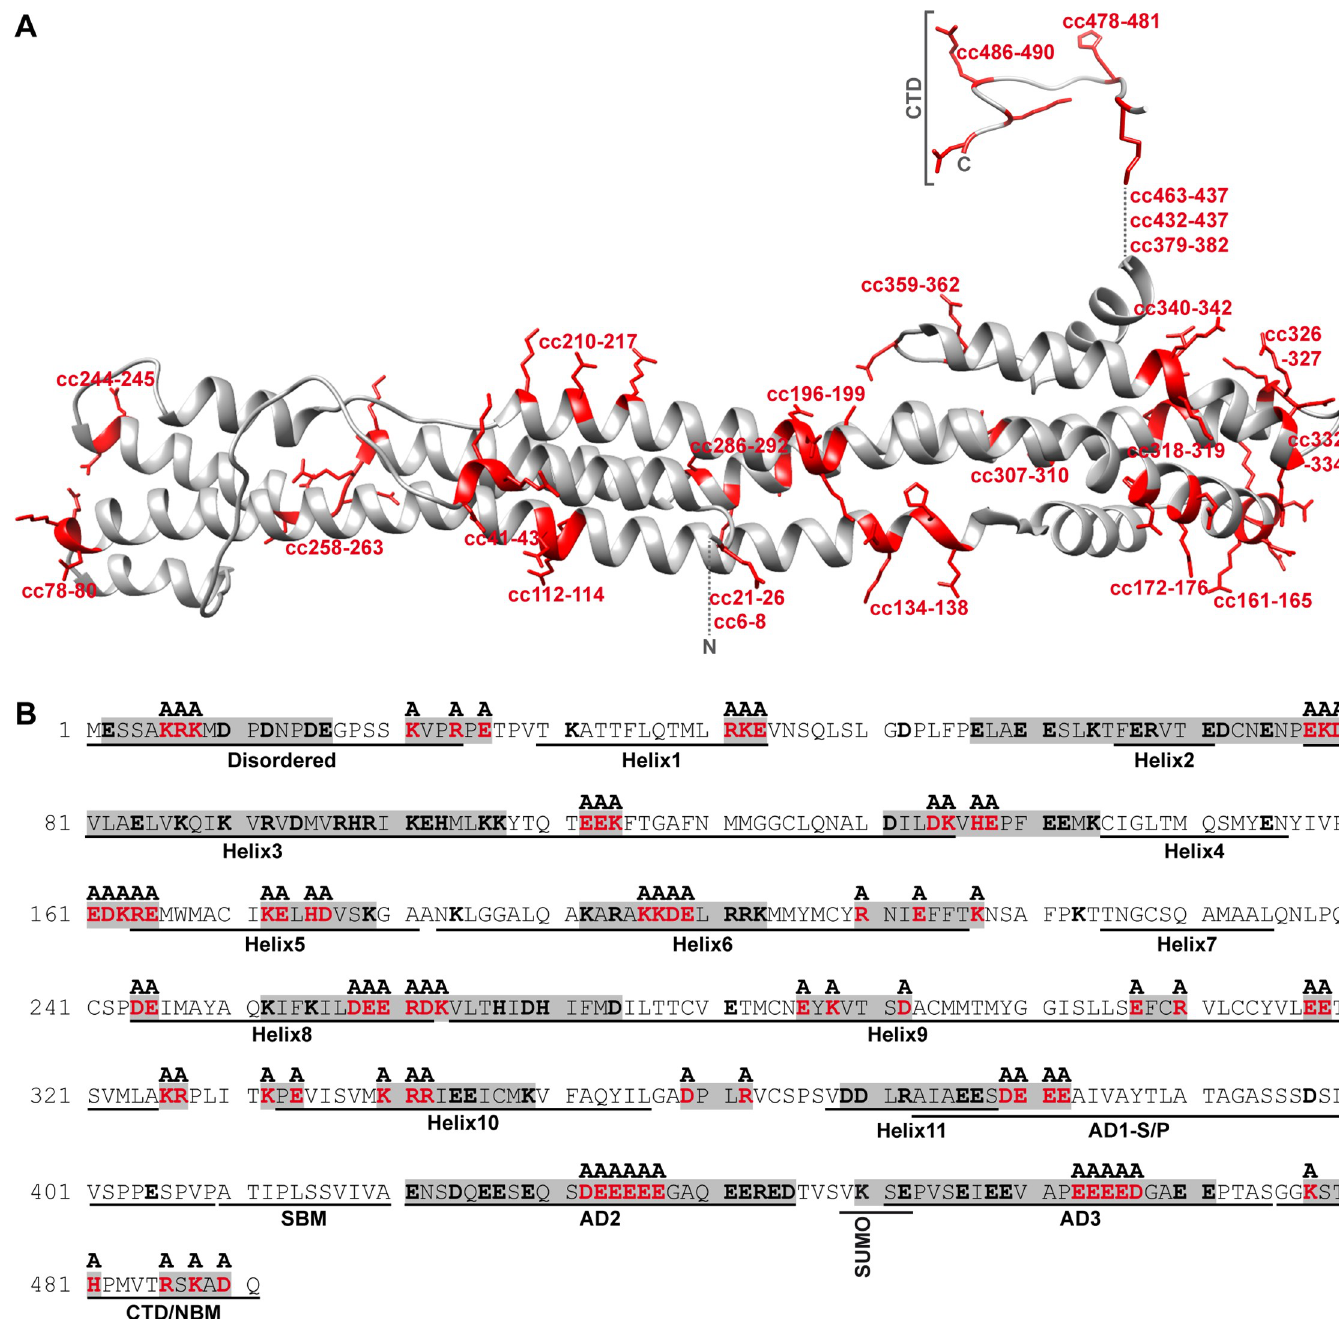
Fig 1. Design of clustered charge-to-alanine IE1 mutants. (A) Tertiary protein structure of hCMV IE1 showing the core domain modelled on the orthologous domain of rhCMV IE1 (PDB 4WID) [49] using Phyre2 and the C-terminal CTD (PDB 5E5A) [62]. The three-dimensional structures of the N-terminal domain and the ‘acidic domain’ (both replaced by dotted lines) have not been determined but are predicted to be disordered. Residues substituted with alanine in the indicated 24 clustered charge (‘cc’) mutants are shown in red. (B) Primary protein structure of hCMV IE1 showing charged residues (bold) and the 24 clustered charges (gray boxes). Residues substituted with alanine in the clustered charge mutants are shown in red. The presumably disordered N-terminal domain, the 11 α -helices (predicted based on rhCMV IE1) [49] composing the core domain, the low complexity motifs (AD1, S/P, AD2 and AD3) [45] of the presumably disordered ‘acidic domain’, the STAT binding motif (SBM) [52] and the CTD [59] including the NBM [92] are indicated. The SUMOylation motif and SUMO attachment site (lysine 450) are marked as well.